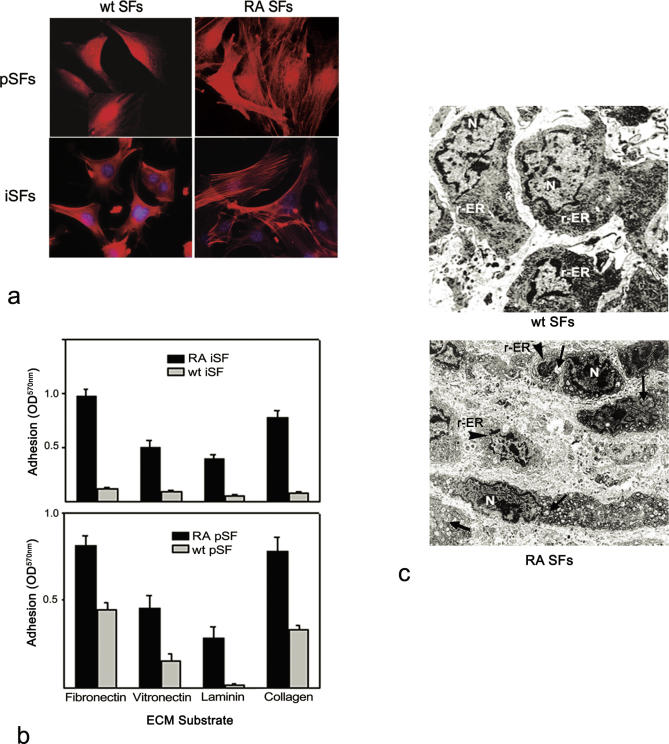
Mouse Arthritic SFs have a Rearranged Cytoskeleton and Increased ECM Adhesion(A) Immunofluoresence of arthritic (RA) or normal (WT) primary and immortalized synovial fibroblasts (pSFs and iSFs respectively) for F-actin.(B) Adhesion assays of arthritic (RA) or normal (WT) primary and immortalized SFs on purified ECM components as described in Materials and Methods. Error bars indicate standard deviation of triplicate samples from their mean value.(C) Transmission electron microscopy (TEM, magnification 5,000×) of SFs from ankle joints isolated from WT and arthritic mice. Arrowheads indicate dilation r-ER, while arrows point to swollen mitochondria with distorted cristae. N, nuclei.